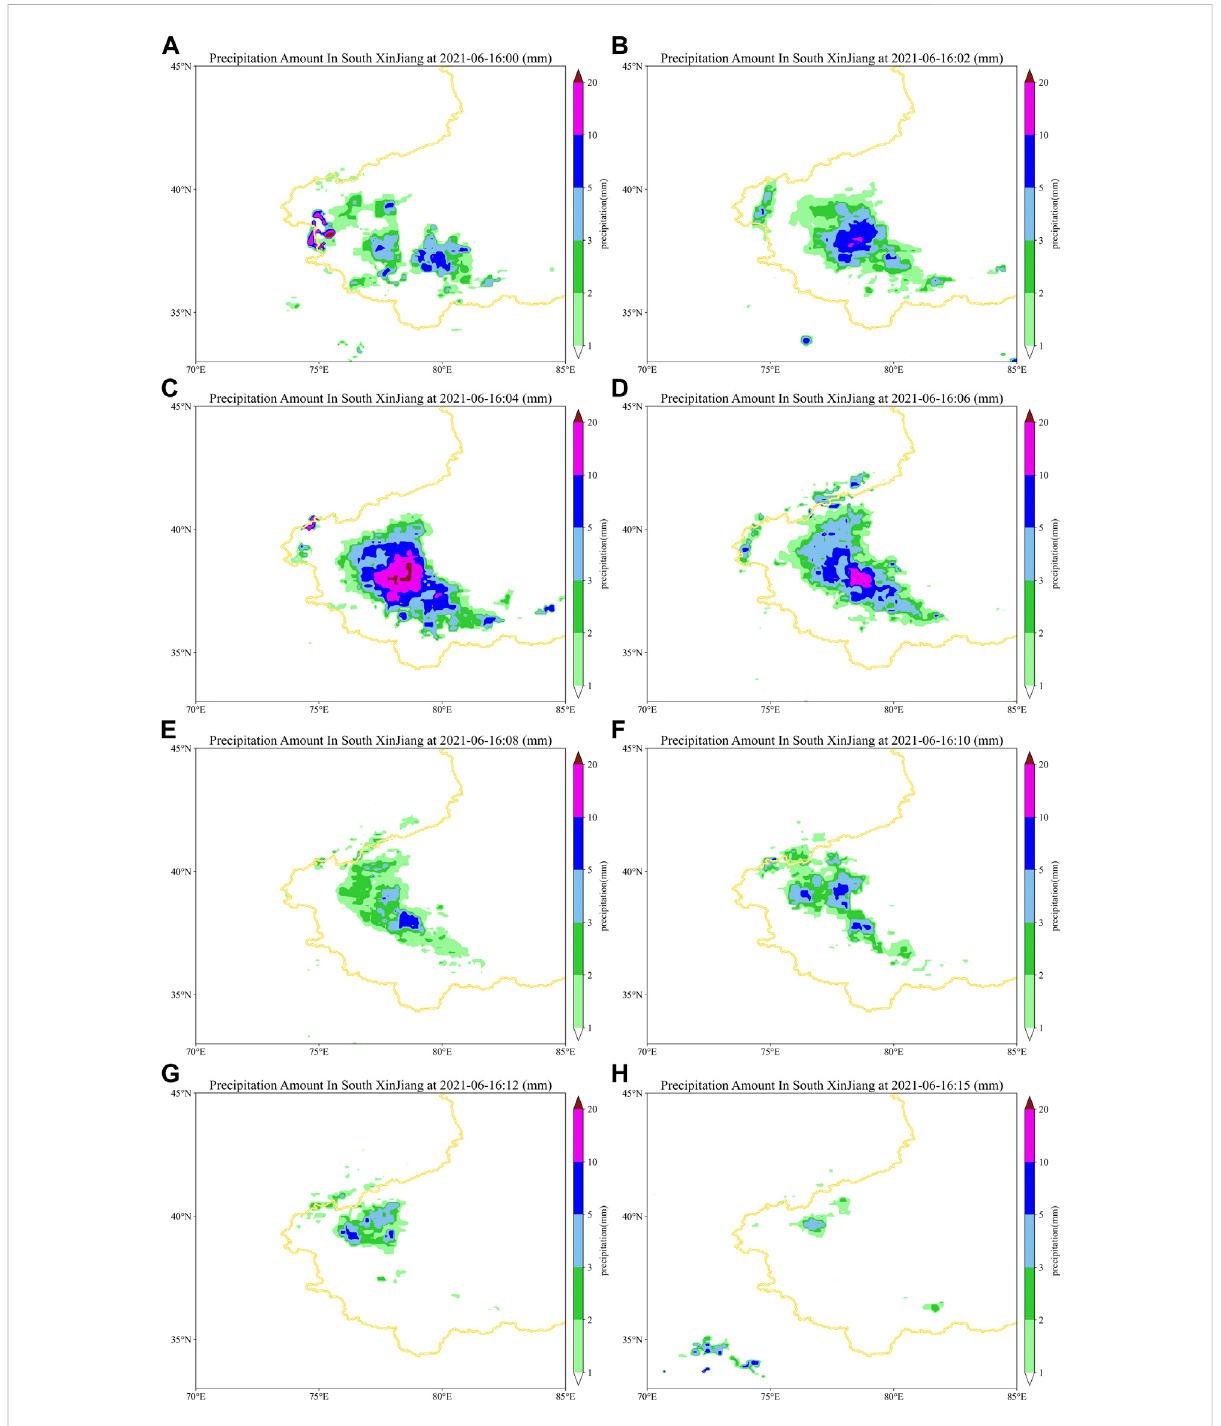
FIGURE 5 Hourly precipitation (mm) from 00:00 to 15:00 (A – H) on 16 June